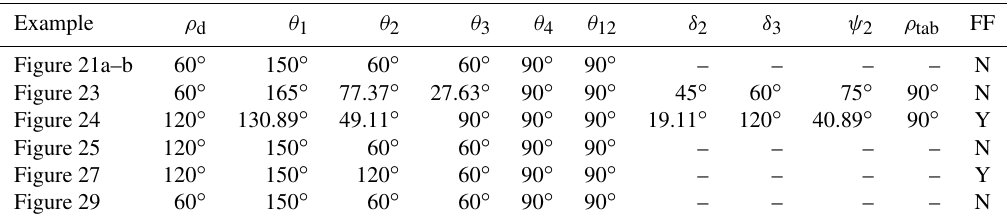
Table A3. Parameter values for sector panel ThUDS examples. Parameters marked “–” are not part of the technique used to create that prototype. Whether flat foldability (FF) is possible is denoted in the last